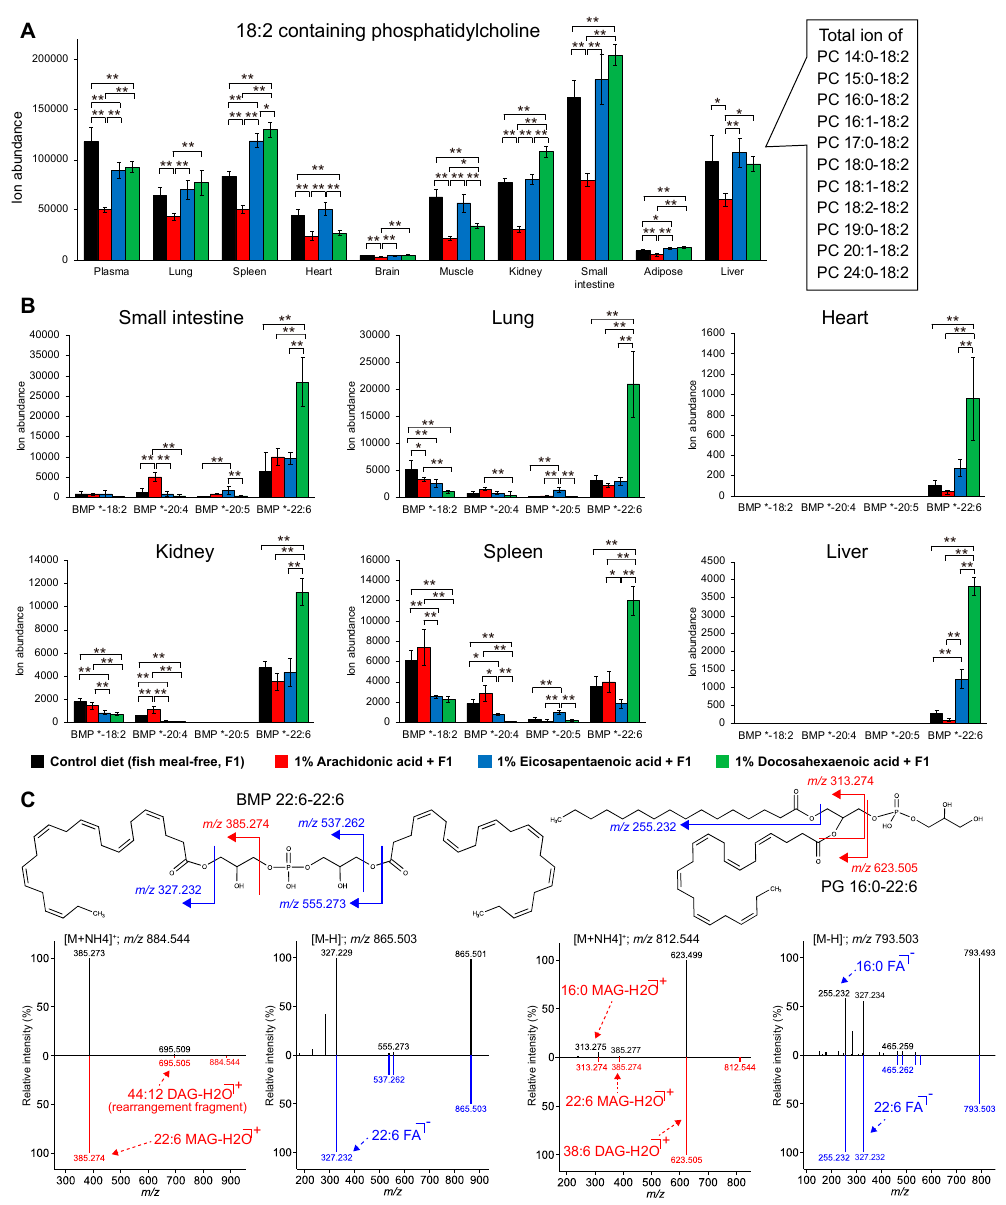
Figure 5. Unique lipid modulations in ARA or DHA dietary intakes. ( a ) The profile of phosphatidylcholines containing linoleic acid (18:2) as the longest PUFA chain and the ion abundances of each molecule. Note that a hyphen has been used for the description of acyl chains, e.g., 18:0-18:2, because the sn1 / sn2 acyl chain structural isomers were not distinguished in this study. ( b ) The profile of bis(monoacylglycero)phosphate (BMP): the asterisk (*) means any of the fatty acids and the ion abundances of lipids containing 18:2, 20:4, 20:5, or 22:6 were summed for quantification. Black, red, blue, and green represent the dietary conditions: control, ARA, EPA, and DHA supplementation, respectively. The statistical significance was evaluated by Tukey’s testing (* P < 0.05 and ** P < 0.01) where one-way ANOVA showed the statistical significance among groups ( P < 0.05). ( c ) The experimental positive and negative ion mode MS/MS spectra (black color) of BMP 22:6-22:6 and PG 16:0-22:6 with the in silico reference spectrum (red color for ESI(+)-MS/MS and blue color for ESI( − )-MS/MS). The cleaved places generating the major fragment ions are described by red color for ESI(+)-MS/MS and blue color for ESI( − )-MS/MS. The product ion of m/z 695.5 from BMP 22:6-22:6 in positive ion mode was interpreted as the result of structural rearrangement in the fragmentation process.